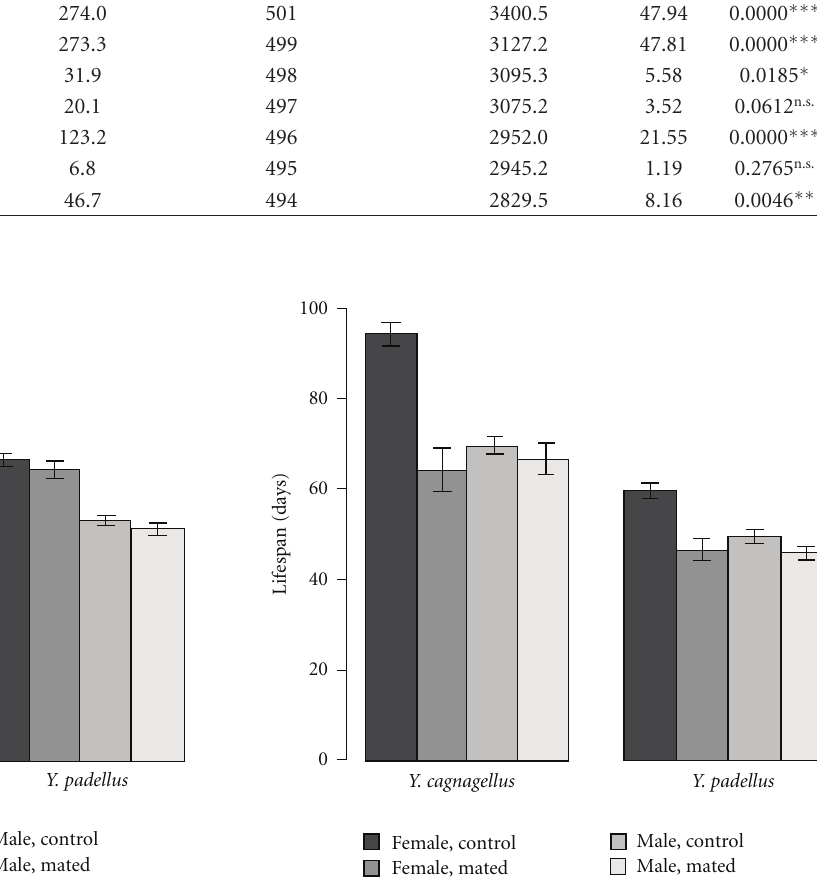
Figure 1: Estimated pupal weights (in mg) at the day of eclosion as a function of species ( Yponomeuta padellus or Yponomeuta cagnagellus ), sex, and mating status (virgin control or once mated).